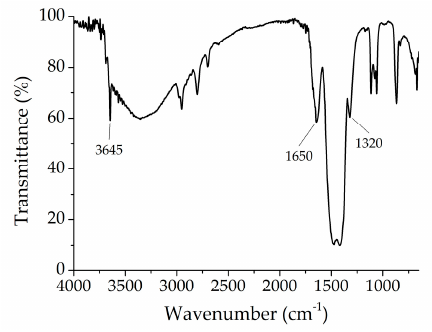
Figure 2. μ FT-IR spectrum showing the reaction pathway of Ca(OEt) 2 . Figure 2. µ FT-IR spectrum showing the reaction pathway of Ca(OEt)